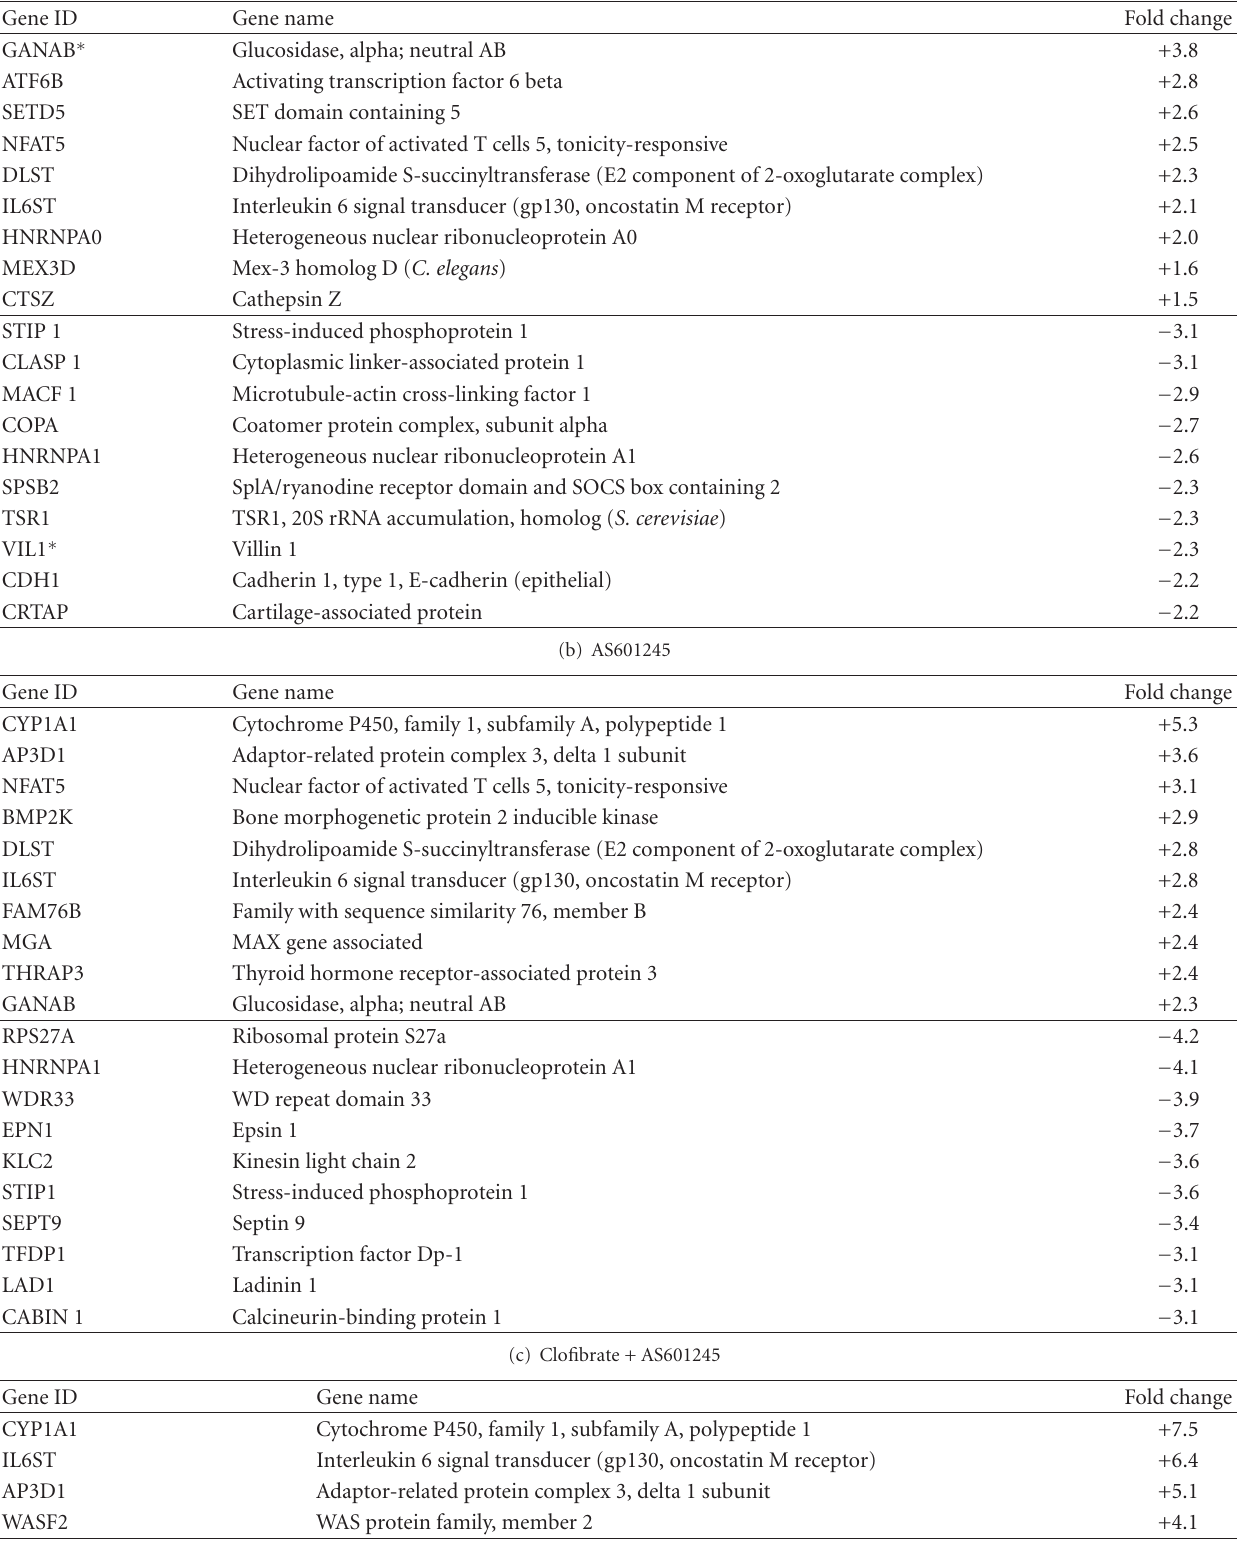
Table 1: Top ten genes b